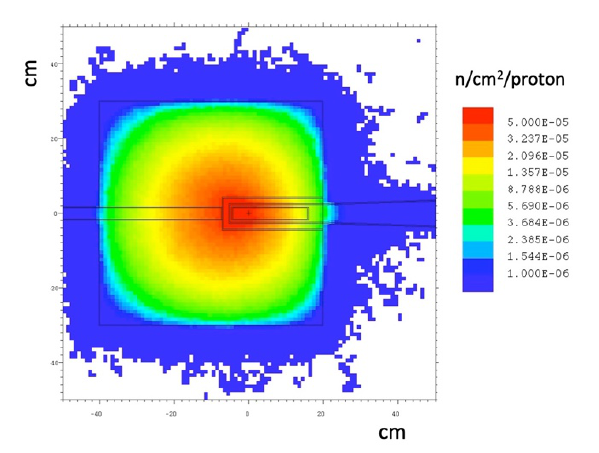
Fig. 3. Low energy ( E < 0.4 eV) neutron fluence map for the 1- target configuration.